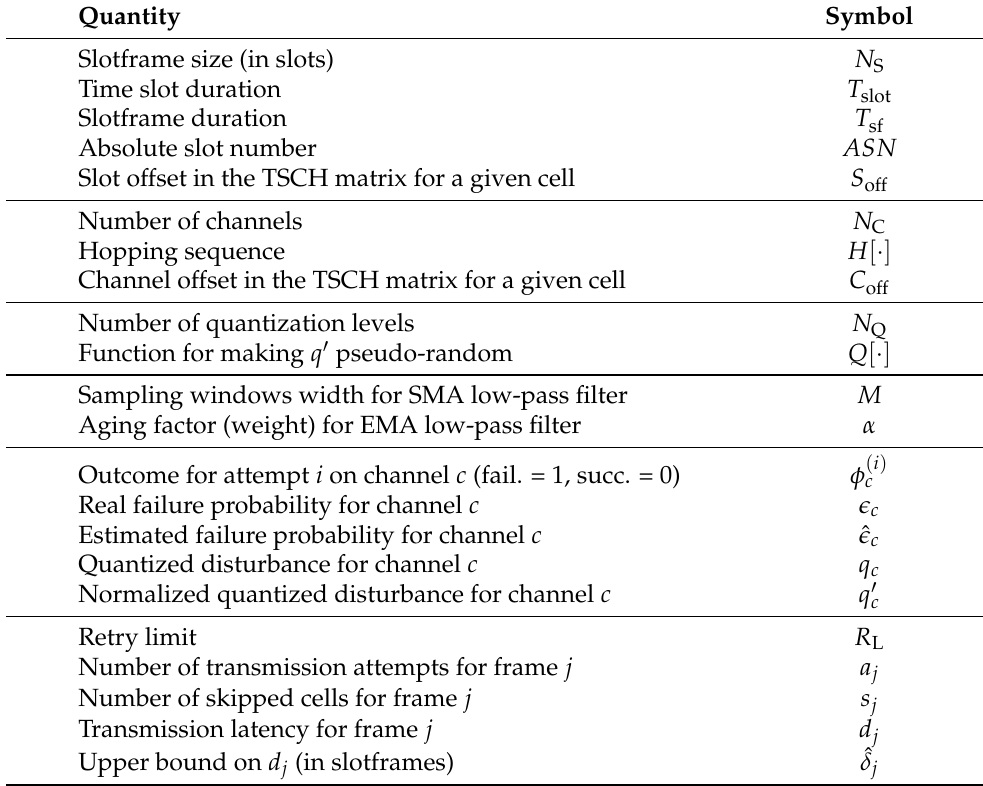
Table 1. Summary about